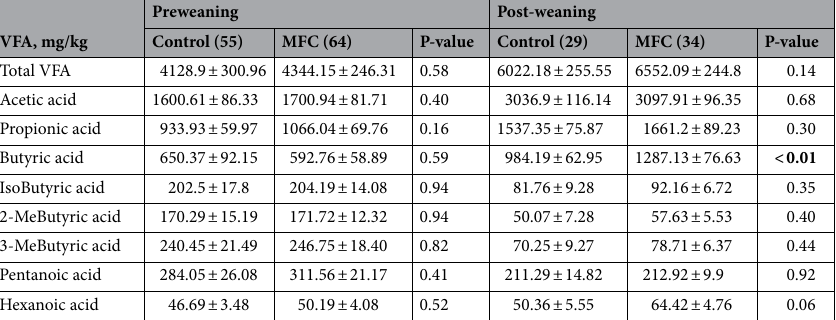
Table 2. Effects of MFC supplementation on fecal volatile fatty acids content of pre-weaning and post- weaning piglets. VFA volatile fatty acid; Control CC at weaning, and CCC at post-weaning; MFC MM at weaning, and MMM at